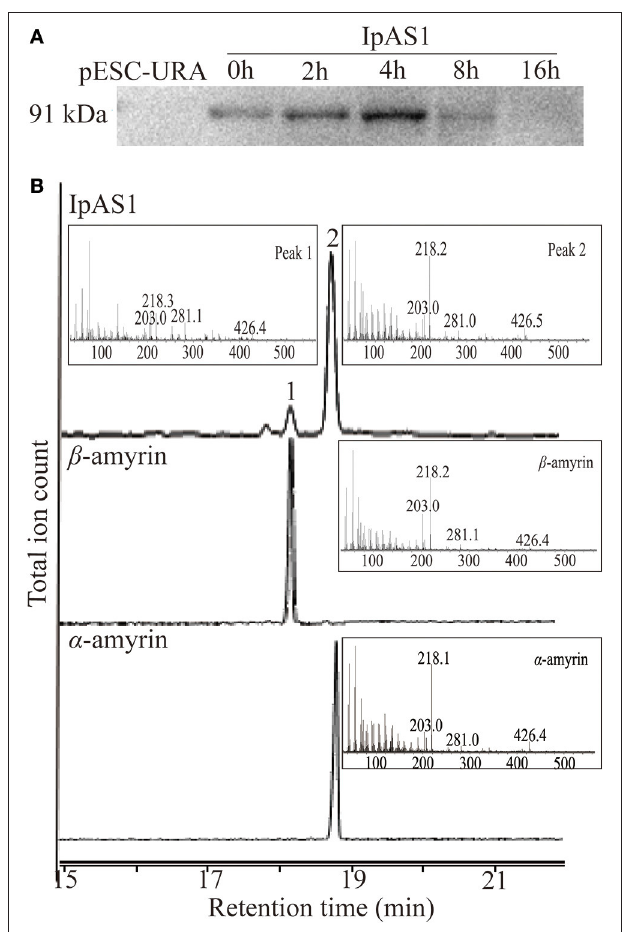
FIGURE 4 | Functional identification of IpAS 1. (A) Western blot analysis of IpAS 1 expressed in S. cerevisiae INV sc 1. Equal amount of yeast cells were harvested at five different time points during 16 h of induction by Gal (0, 2, 4, 8, and 16 h), which showed that IpAS 1 was successfully expressed during the whole induction, with a maximum band intensity observed at 4 h. (B) GC-MS analysis of yeast metabolites after expression of IpAS 1. By comparing the retention times and mass fragment patterns with authentic standards, two compounds were identified as α - and β -amyrin, respectively, which indicates IpAS1 is a mixed AS.